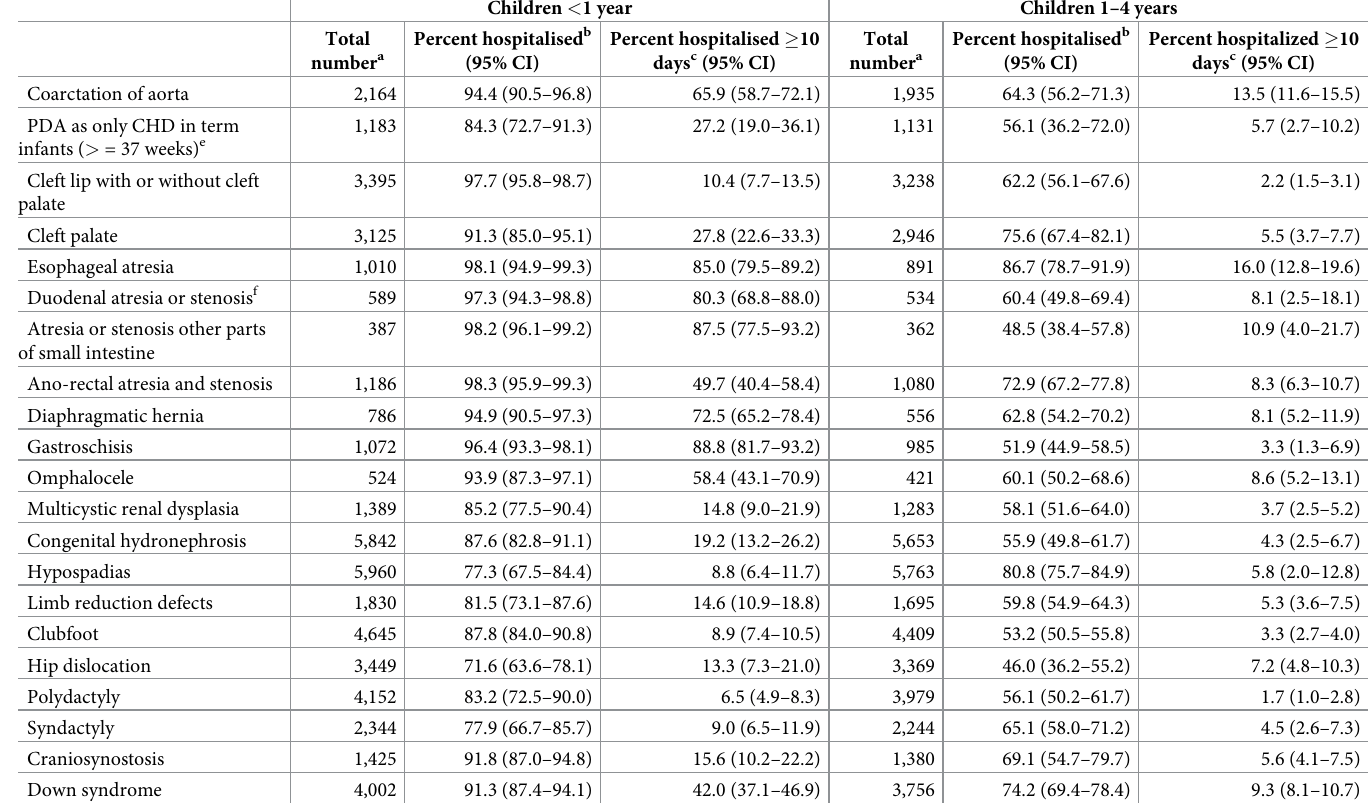
Measures of heterogeneity, including the I 2 statistic and number of registers included in each meta-analysis of percentage hospitalised can be seen in S3A and S3B Table. Fig 1 shows the estimated pooled percentage of children hospitalised as well as the registry- specific percentages hospitalised in the age group 1–4 years for the reference children and three selected anomaly subgroups: severe CHD, ano-rectal atresia and stenosis (as the most frequent gastro-intestinal anomaly) and Down syndrome. The percentage of reference chil- dren hospitalised was lower in the Valencian Region and the Italian registries (E Romagna and Tuscany) and highest in Wales. For severe CHD, the percentage ranged from 35% to 81%